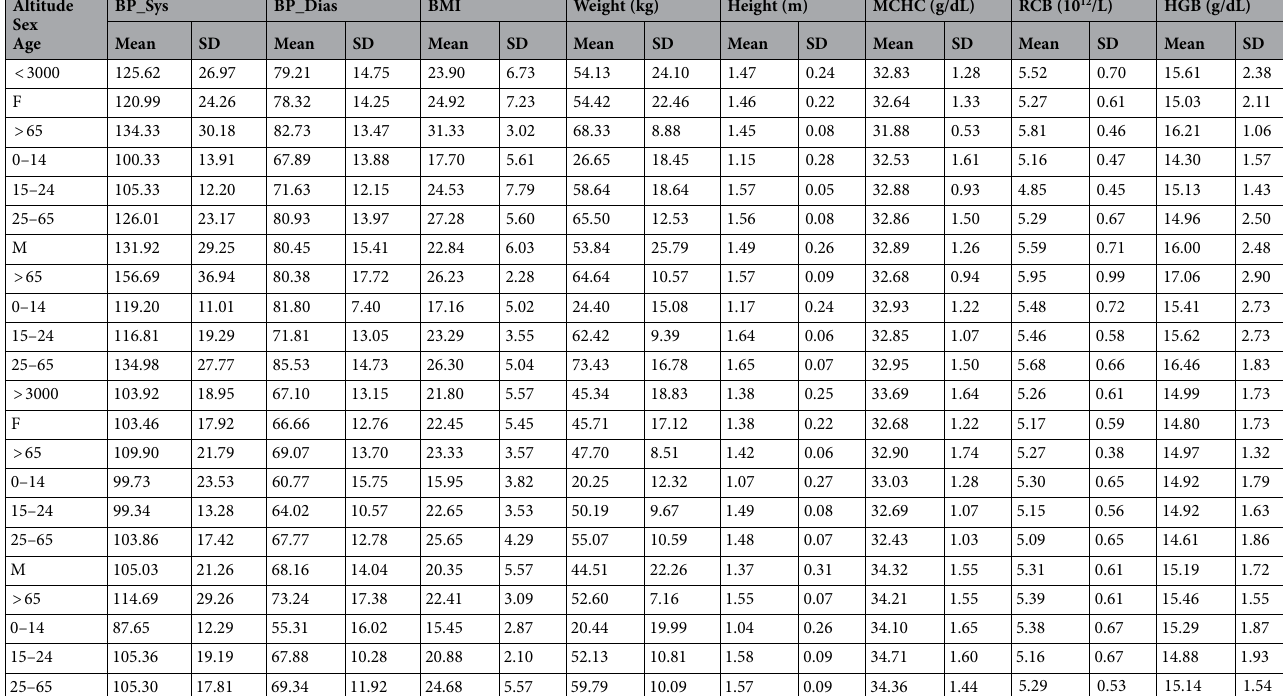
Table 2. Anthropomorphic description of the cohort under study. Data represents the mean and standard deviation for every collapsed variable. BP: Blood pressure; BMI: Body mass